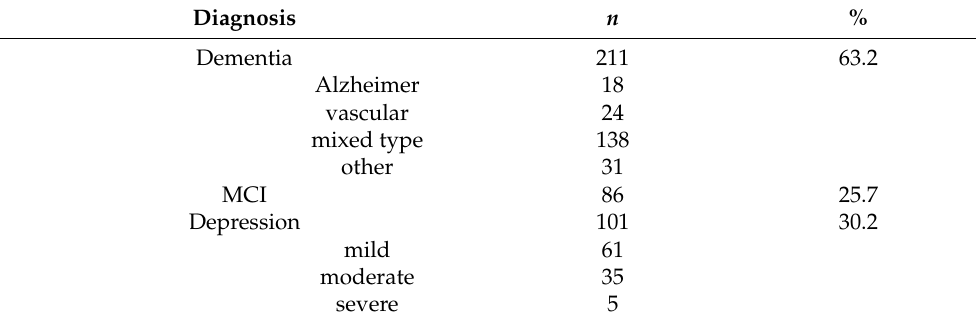
Table 1. Diagnosis groups (multiple answers for dementia/MCI and depression possible).